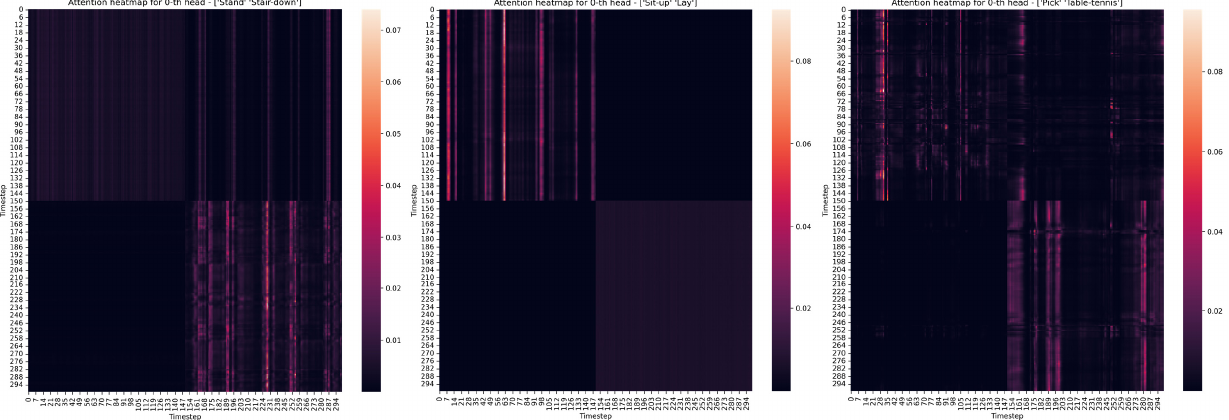
Figure 6. Attention heatmaps of different pairs of activities.